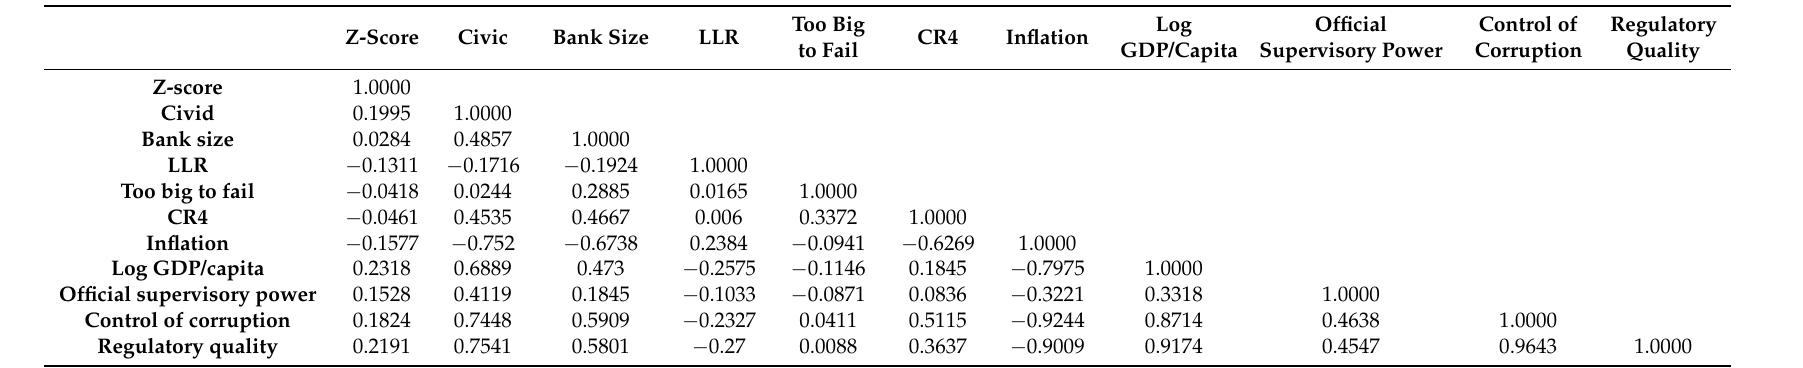
Table 3. Correlation matrix of main regression